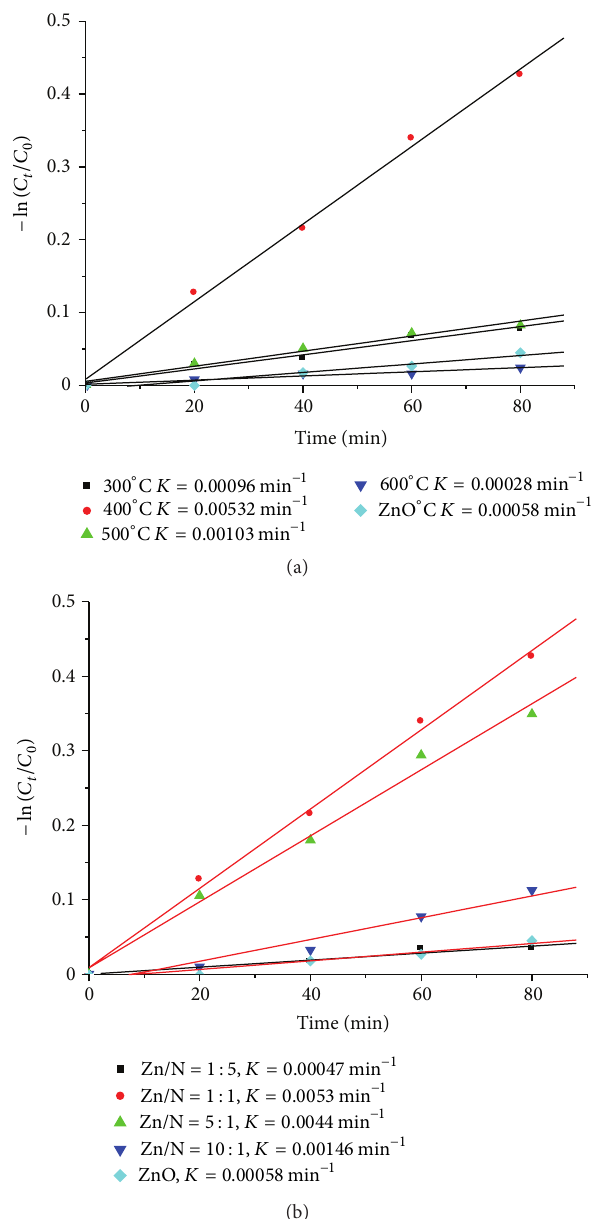
Figure 5: Plots of degradation of KN-R over as-synthesized samples undervisiblelightirradiation;(a)N-dopedZnO/ZnSphotocatalysts with Zn/N = 1 prepared at different temperatures for 2 h. (b) N- doped ZnO/ZnS photocatalysts with various Zn/N ratios prepared at 400 ∘ C for 2 h.